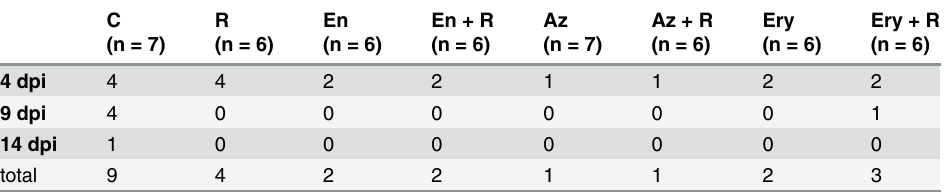
Table 2. Reisolation of Chlamydia psittaci from bronchial